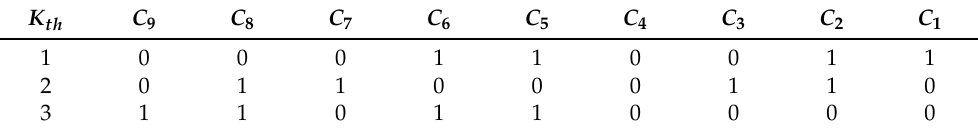
Table 1. Basic MDW code sequence For W = 4 [17].